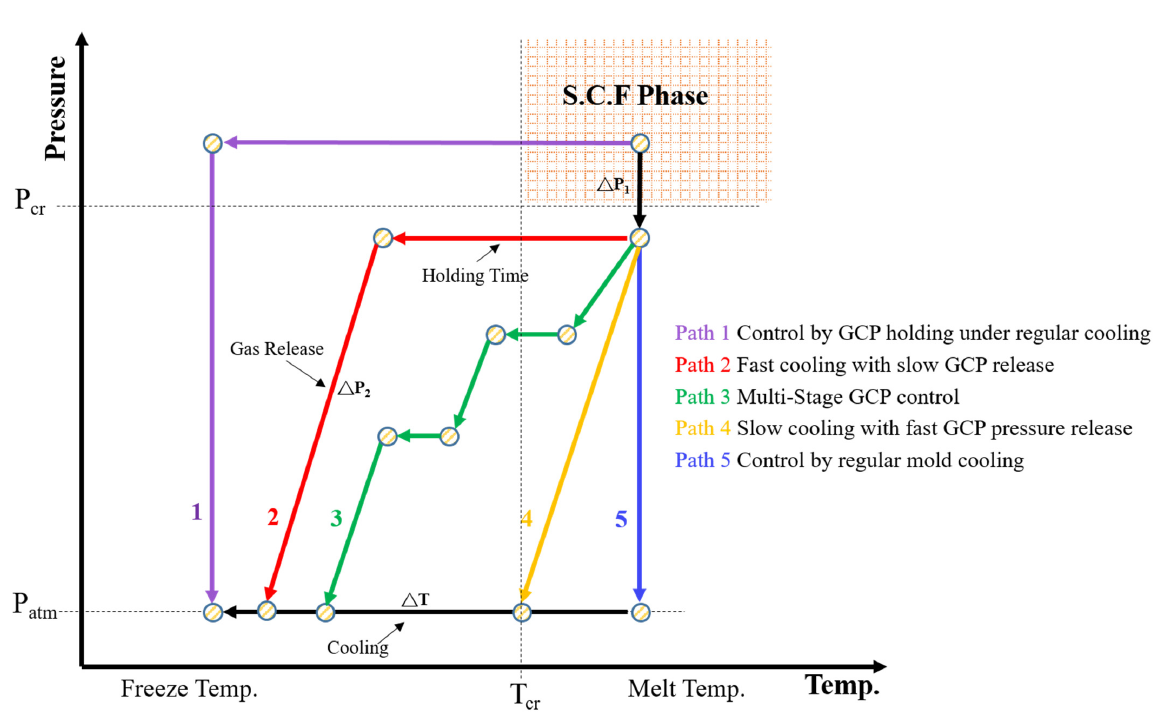
Figure 2. A schematic of various combinations of GCP parameters (pressure value, holding time, and relief time) and cooling speed leading to different P-T paths.